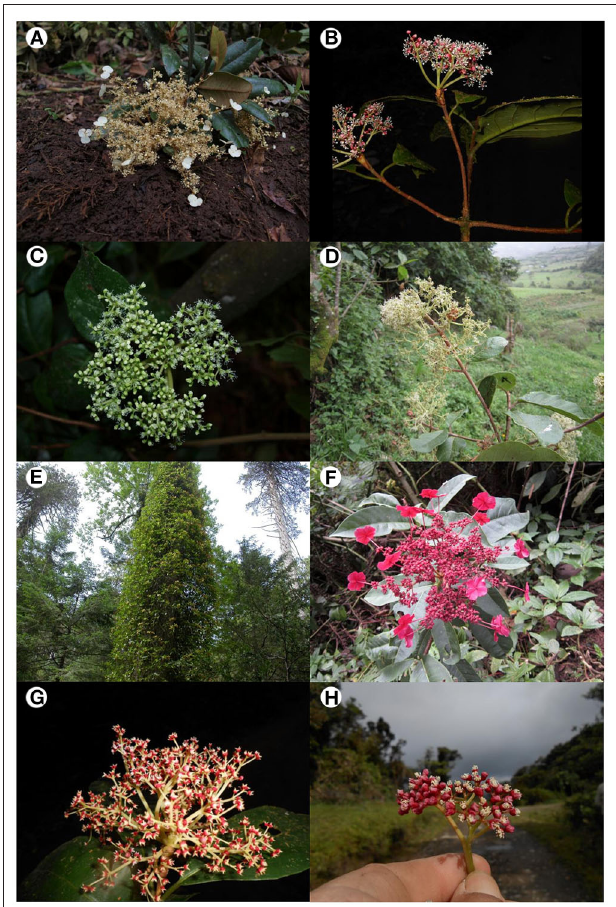
FIGURE 1 | Representative species of Hydrangea section Cornidia : (A) Hydrangea asterolasia , simple inflorescence with male flowers (stamens large, pistils reduced) and enlarged marginal flowers (Ecuador, Granados Mendoza et al., 2012-042, clade J); (B) H. diplostemona , simple inflorescence with male flowers (stamens large, pistils reduced) without enlarged marginal flowers (Costa Rica, Samain, and Martínez Salas 2013-029, clade G); (C) H. ecuadorensis , simple inflorescence with female flowers (pistils large, anthers reduced) without enlarged marginal flowers (Ecuador, Granados Mendoza et al., 2012-067, clade E); (D) H. jelskii , branched inflorescence with male flowers (stamens large, pistils reduced) without enlarged marginal flowers (Peru, Samain et al., 2011-063, clade F); (E) H. seemannii , flowering plant growing on coniferous tree (Mexico, Granados Mendoza et al., 483, clade A); (F) H. weberbaueri , simple infructescence with immature fruits (Peru, Samain et al., 2011-062, epitype, clade H); (G) H. diplostemona , simple inflorescence with female flowers (pistils large, stamens reduced) without enlarged marginal flowers (Costa Rica, Samain and Martínez Salas, 2013-028, clade G); and (H) H. oerstedii , central cyme of inflorescence (enlarged marginal flowers not included) with female flowers (pistils large, stamens reduced) (Costa Rica, Samain and Martínez Salas, 2013-022, clade D). Clade names correspond to those discussed in the